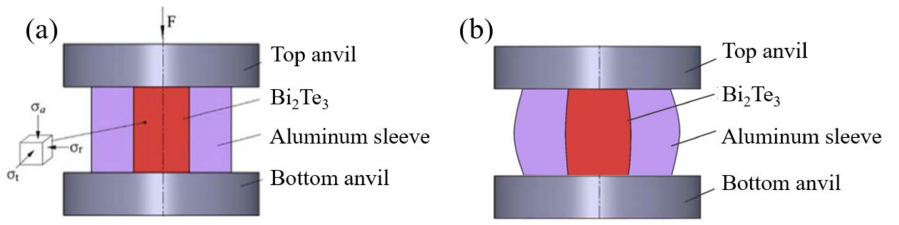
Figure 1. Schematic diagram of constrained hot compression molding (CHCM) technique: ( a ) before and ( b ) after compression.